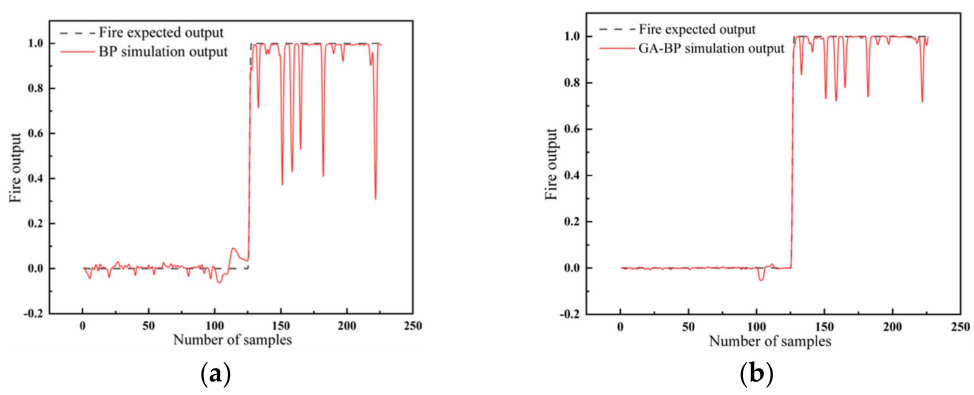
Figure 8. The output results of fire with ( a ) the BPNN and ( b ) the GA-BPNN. The PSO-LSSVM fire warning model adopted four kernel functions: (1) the radial basis kernel function; (2) the sigmoid kernel function; (3) the polypolynomial kernel